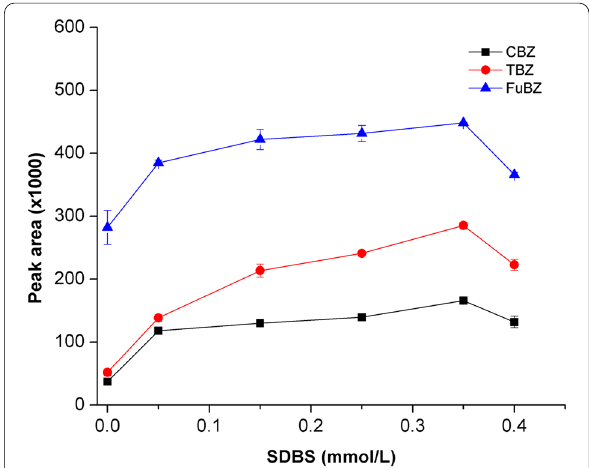
Fig. 3 Effect of MgCl 2 on the extraction performance of target fungicides (100 µg/L each). Conditions: 300 mmol/L MgCl 2 , 0.5 mol/L NaOH (200 μL), and 10 mmol/L SDBS (350 μL)